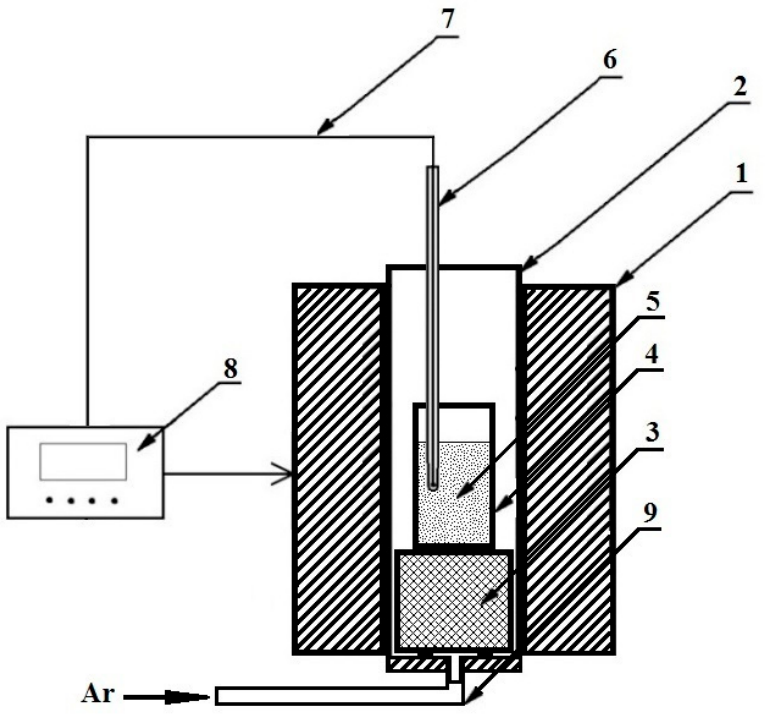
Figure 2. Schematic of the Tamman resistance furnace (1—furnace; 2—graphite heater; 3—graphite stands; 4—crucible; 5—mixture of RM with carbon; 6—thermocouple shield; 7—W-Re thermocouple; 8—automatic temperature controller; 9—gas inlet).